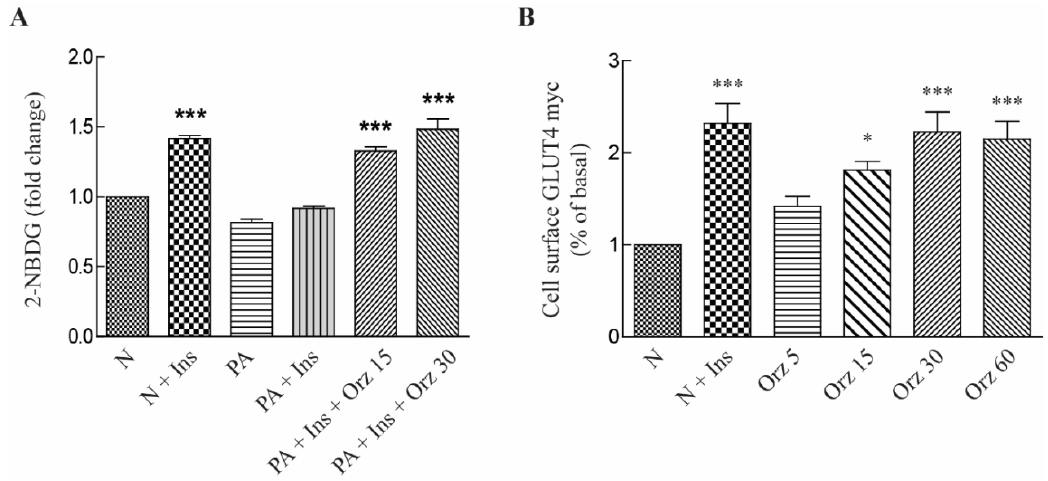
Figure 2. Effects γ-oryzanol (Orz) on glucose uptake and glucose transporter type 4 (GLUT4) translocation. ( A ) Effects of Orz on glucose uptake. 3T3-L1 cells were treated with various concentration of Orz for 18 h. Cells were incubated with 100 nM insulin and 50 μM 2-NBDG for 15 min, followed by incubation with 0.5 mM palmitate for 6 h and then fluorescence intensity of cellular 2-NBDG was measured. ( B ) GLUT4 translocation to the cell membrane was measured in L6-GLUT4myc. Cells were treated with Orz for 24 h or insulin for 10 min. Values are means ± SEM, n = 3, * p < 0.05; ** p < 0.01; *** p < 0.001 compared to normal control. 2-NBDG, 2-( N